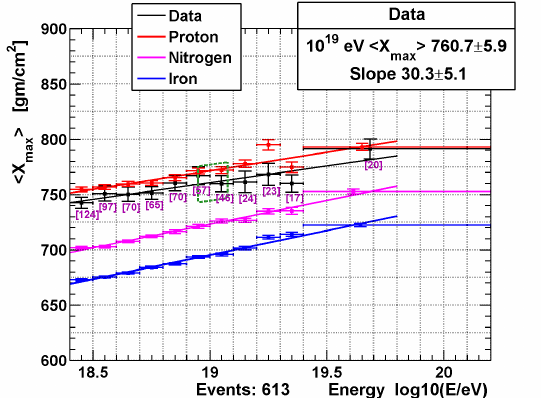
(a) Observed (cid:104) X max (cid:105) of seven years of Middle Drum hybrid data. Figure 1: Middle Drum (cid:104) X max (cid:105) and Cramér-von Mises shift test. The data shows agreement with light composition.